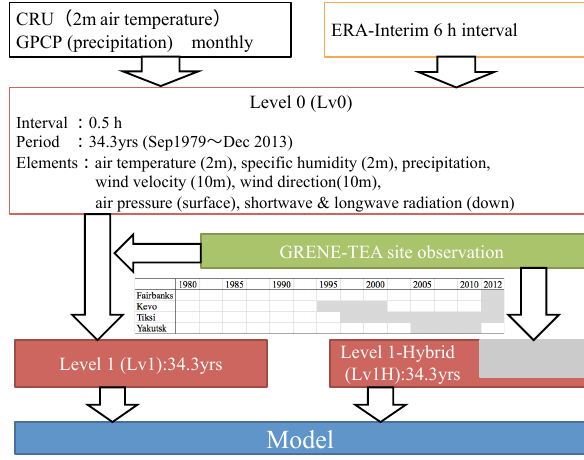
Figure 2. Schematic diagram for data creation during GTMIP Stage